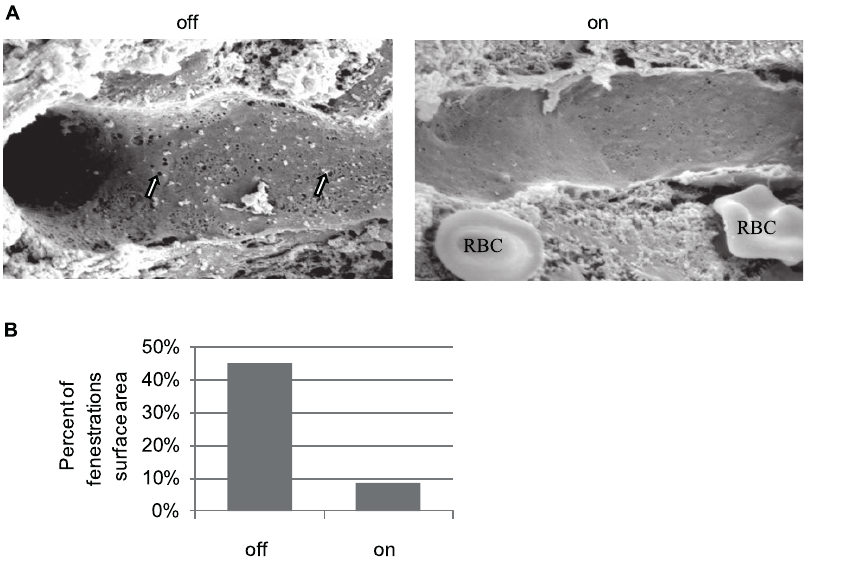
Figure 2. sVEGF-R1 expression in the adult liver causes closure of sinusoidal fenestrations. (a) Scanning electron microscopy of sinusoids in control (‘off’) showing fenestrations arranged in sieve plates (white arrows) and loss of fenestration following one month of switch ‘on’ (sVEGF-R1 expression). RBC=Red Blood Cell (b) Quantification of the percent of fenestrations’ surface area in the sinusoids. sinusoidal area. ‘off’ 2 40.5%, ‘on’ 2